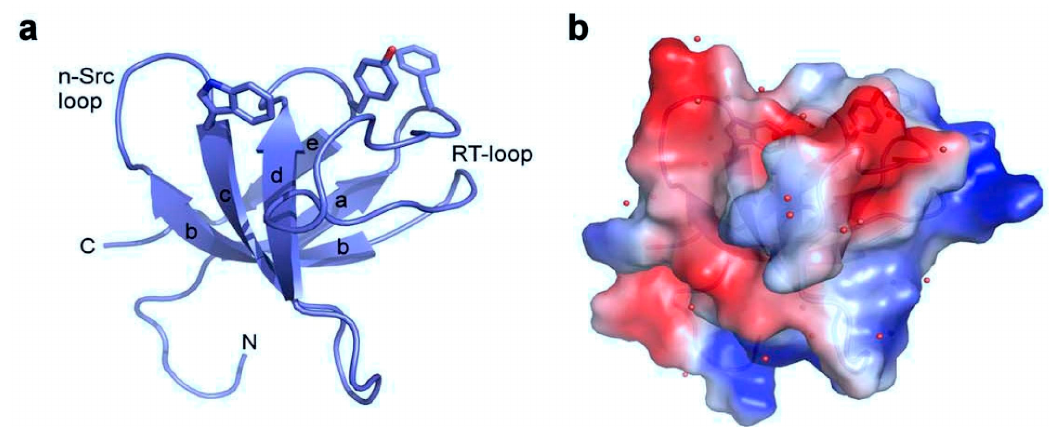
Figure 6. Structure of the second SH3 domain of ponsin as derived from XRPD data. ( a ) Ribbon representation of the protein domain emphasizing the secondary structure elements, where the main hydrophobic regions and loops are indicated. ( b ) Electrostatic potential representation (using PYMOL) of the domain identifying additionally the water molecules as red spheres [11].